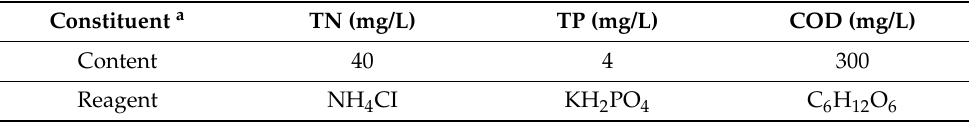
Table 1. Artificial sewage water characteristics.